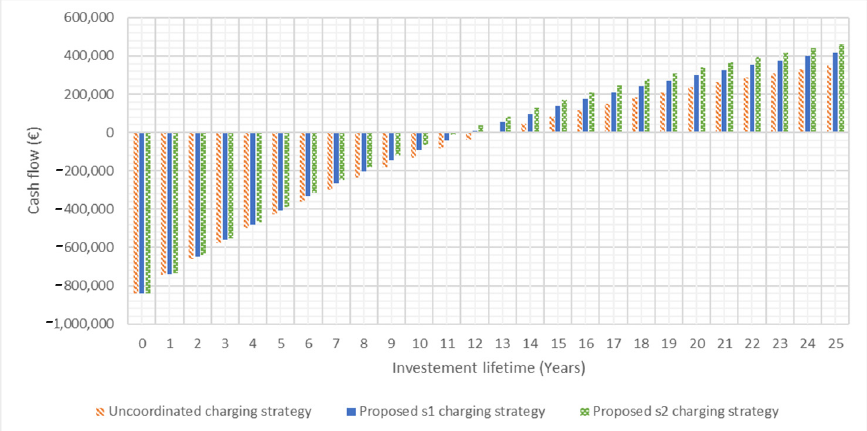
Figure 12. Accumulated present value savings and revenue throughout the investment years (PV = 1000 kWp).